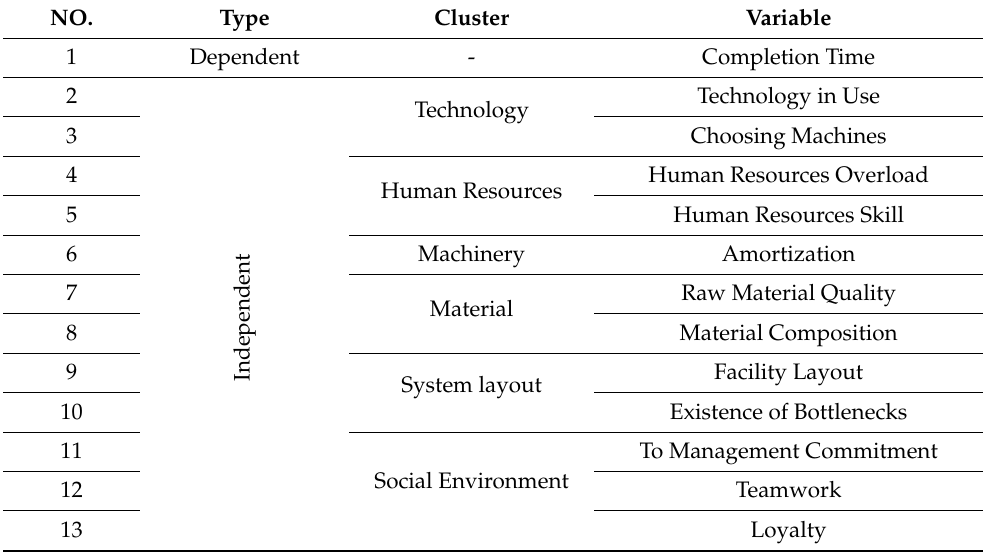
Table 1. Dependent and independent variables of the